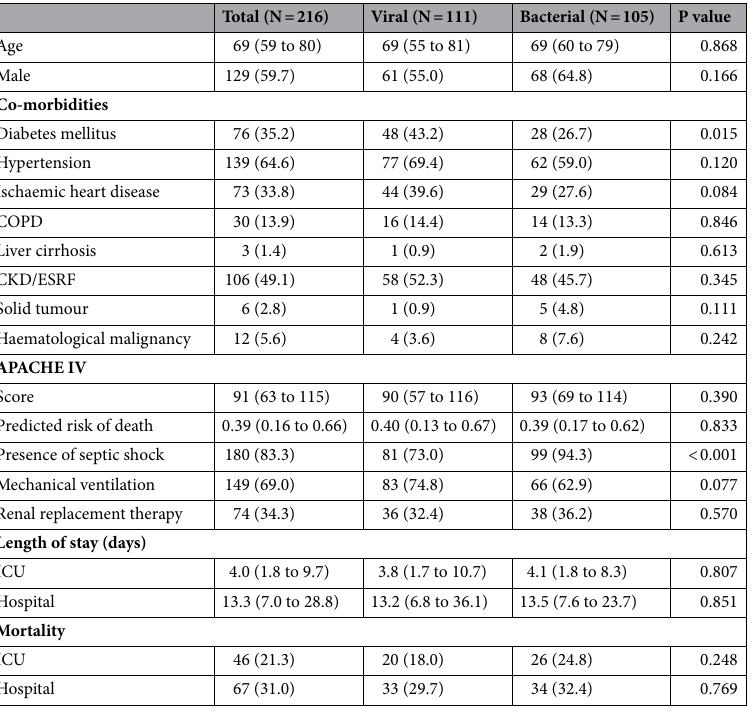
Table 1. Comparison of patient demographics and outcome parameters between viral and bacterial pneumonia. COPD chronic obstructive pulmonary disease, CKD/ESRF chronic kidney disease/end-stage renal failure, APACHE IV Acute Physiology and Chronic Health Evaluation